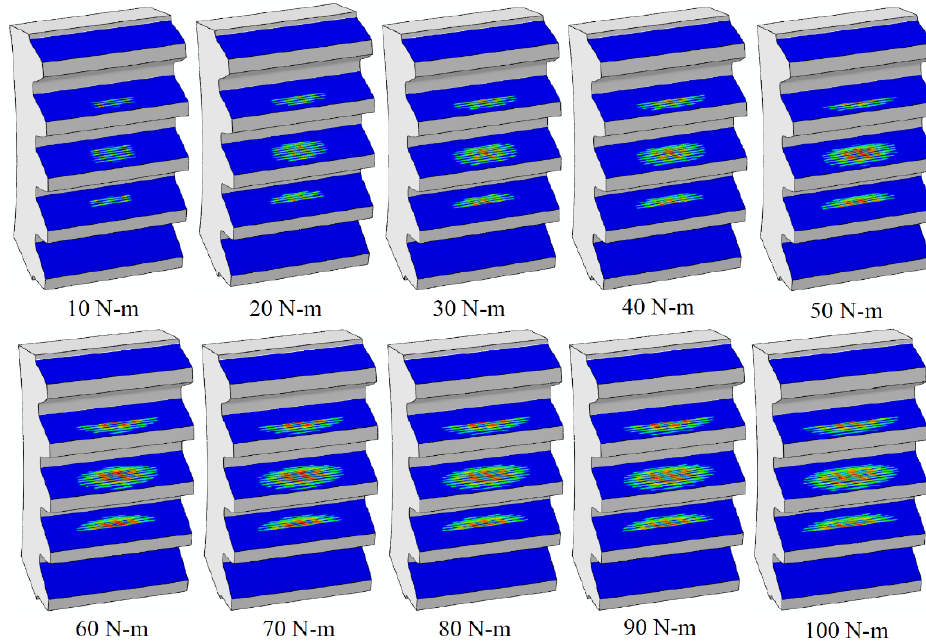
Figure 4. Simulated contact patterns under various loads.